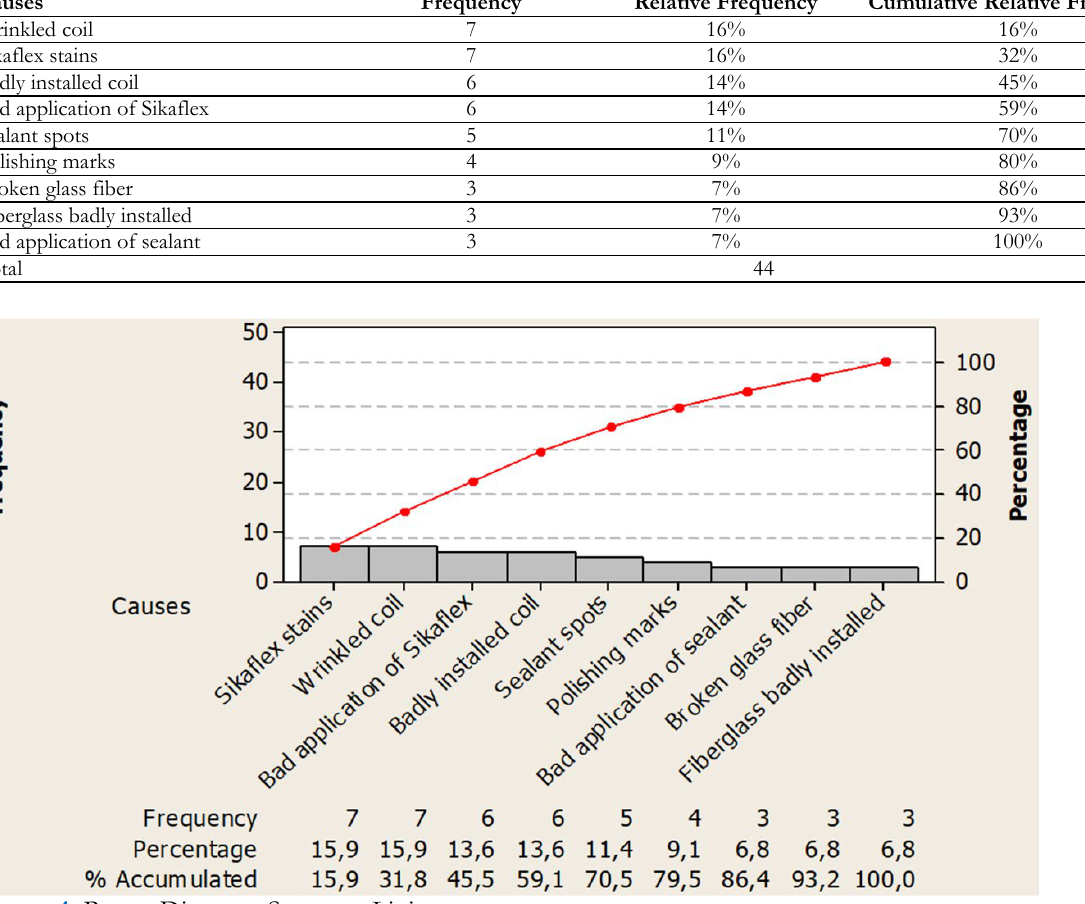
Figure 4. Pareto Diagram- Structure Lining